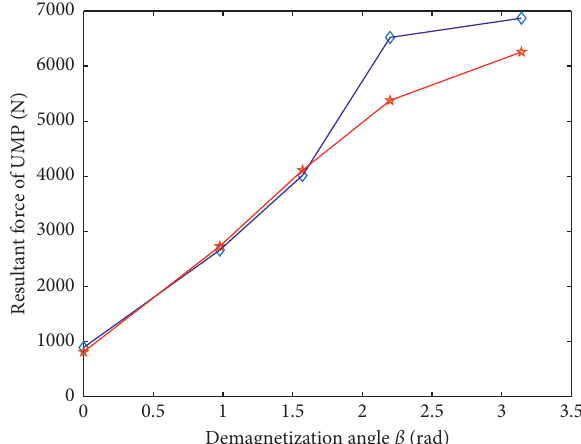
Figure 5: The diagram of UMP trend under the change of de- magnetization angle.